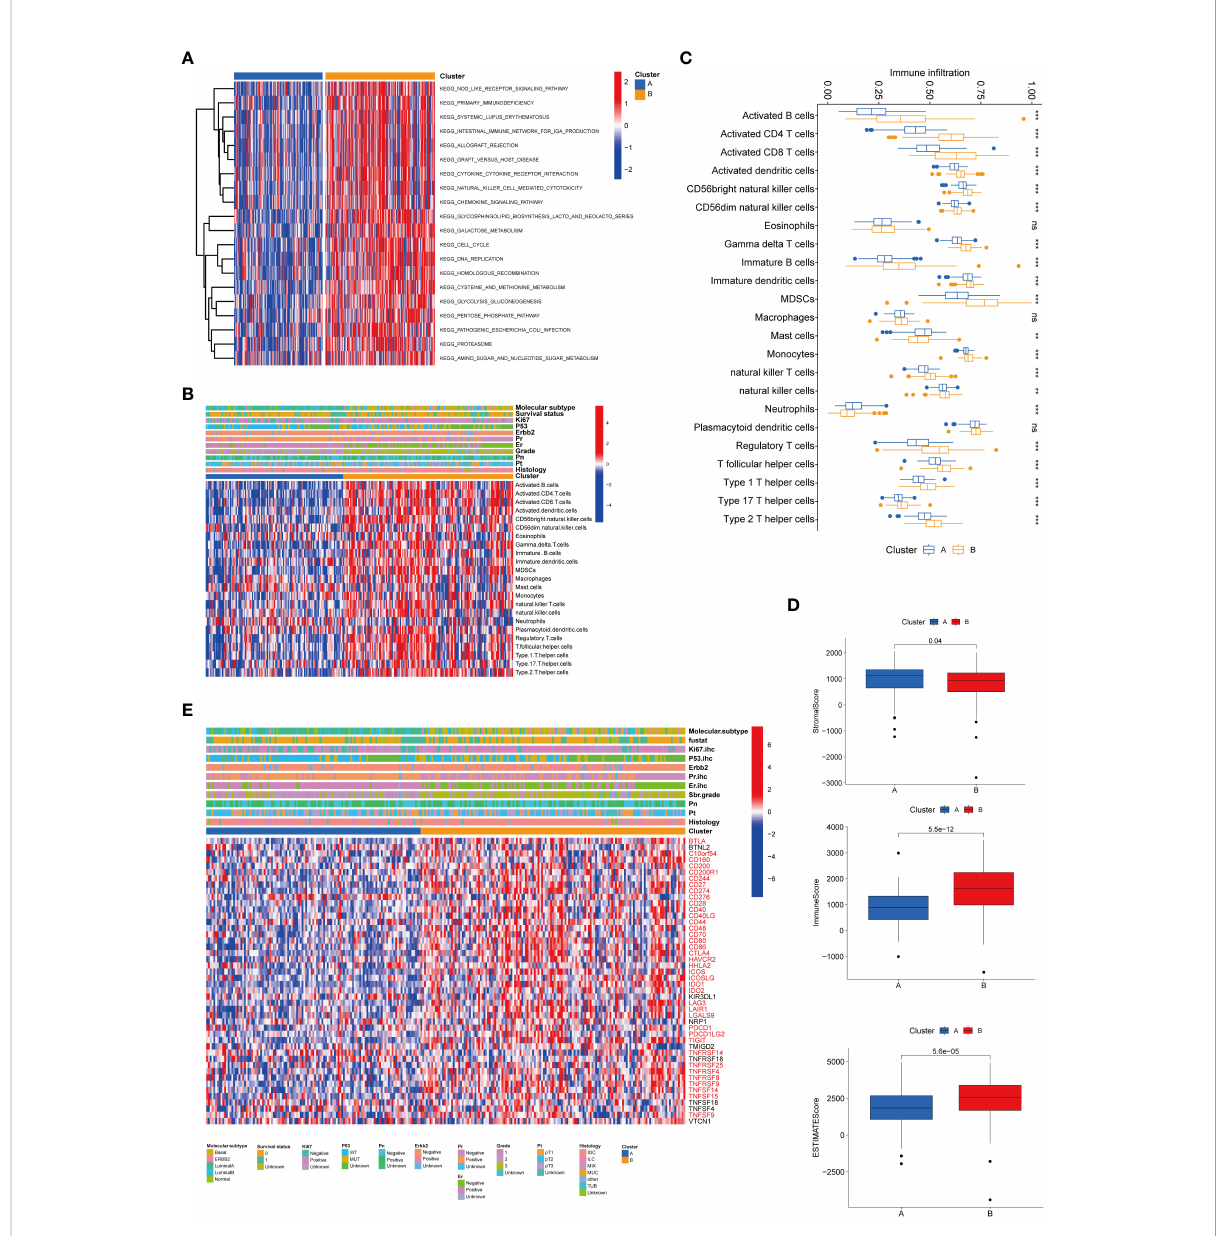
FIGURE 3 Correlations of tumor immune cell microenvironments and two BRCA subtypes. (A) GSVA of biological pathways between the two distinct subtypes, in which red and blue represent activated and inhibited pathways, respectively. (B) Heatmap of the tumor-in fi ltrating cell in the two BRCA subtypes. (C) The abundance of the 23 in fi ltrating immune cell types in the two BRCA subtypes. (D) Correlations between the two subtypes and TME score. (E) Heatmap of immune checkpoints between the two distinct subtypes, in which red represents differently expressed checkpoints. BRCA, breast cancer; GSVA, gene set variation analysis; TME, tumor microenvironment. ** P value < 0.01; *** P value <